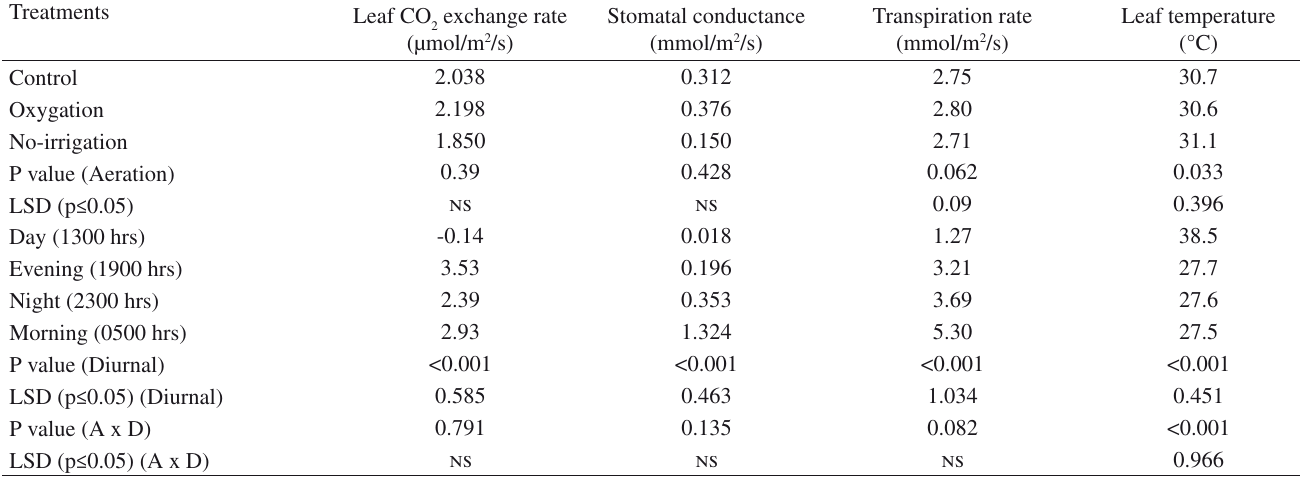
Table 7 - Diurnal variation for leaf CO